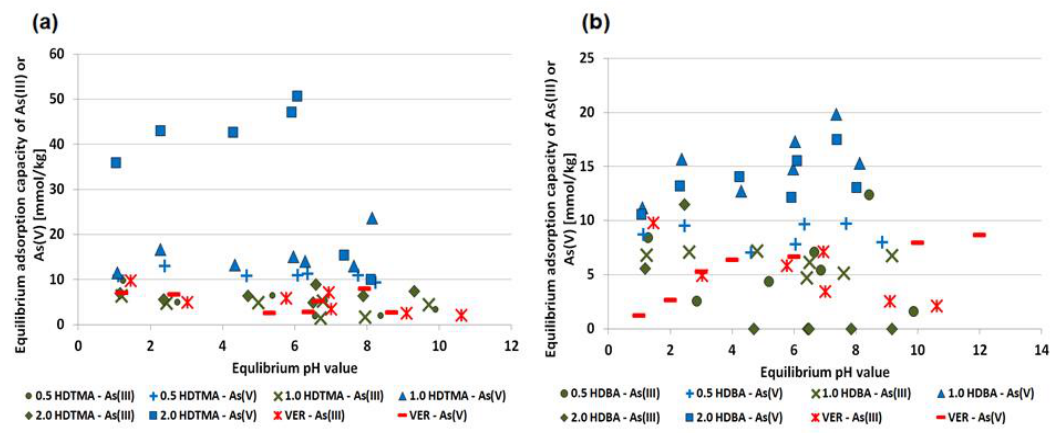
Figure 8. Sorption of As(III) or As(V) ions as a function of equilibrium pH value for ( a ) VER, 0.5 HDTMA, 1.0 HDTMA, and 2.0 HDTMA, and ( b ) VER, 0.5 HDBA, 1.0 HDBA, and 2.0 HDBA.